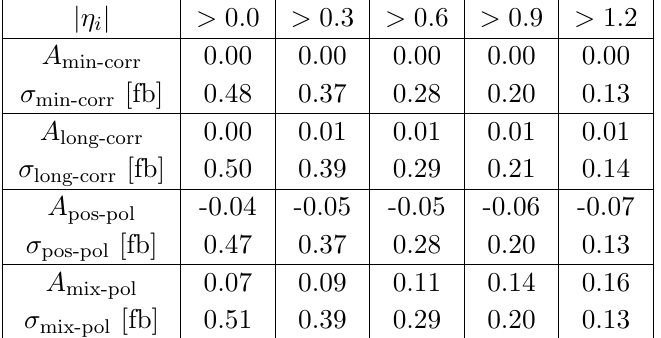
Table 3 . Asymmetries and DPS cross sections for di(cid:11)erent cuts on the rapiditiy of the individual muons. The larger part of the central detector is removed, the higher values of asymmetry can be